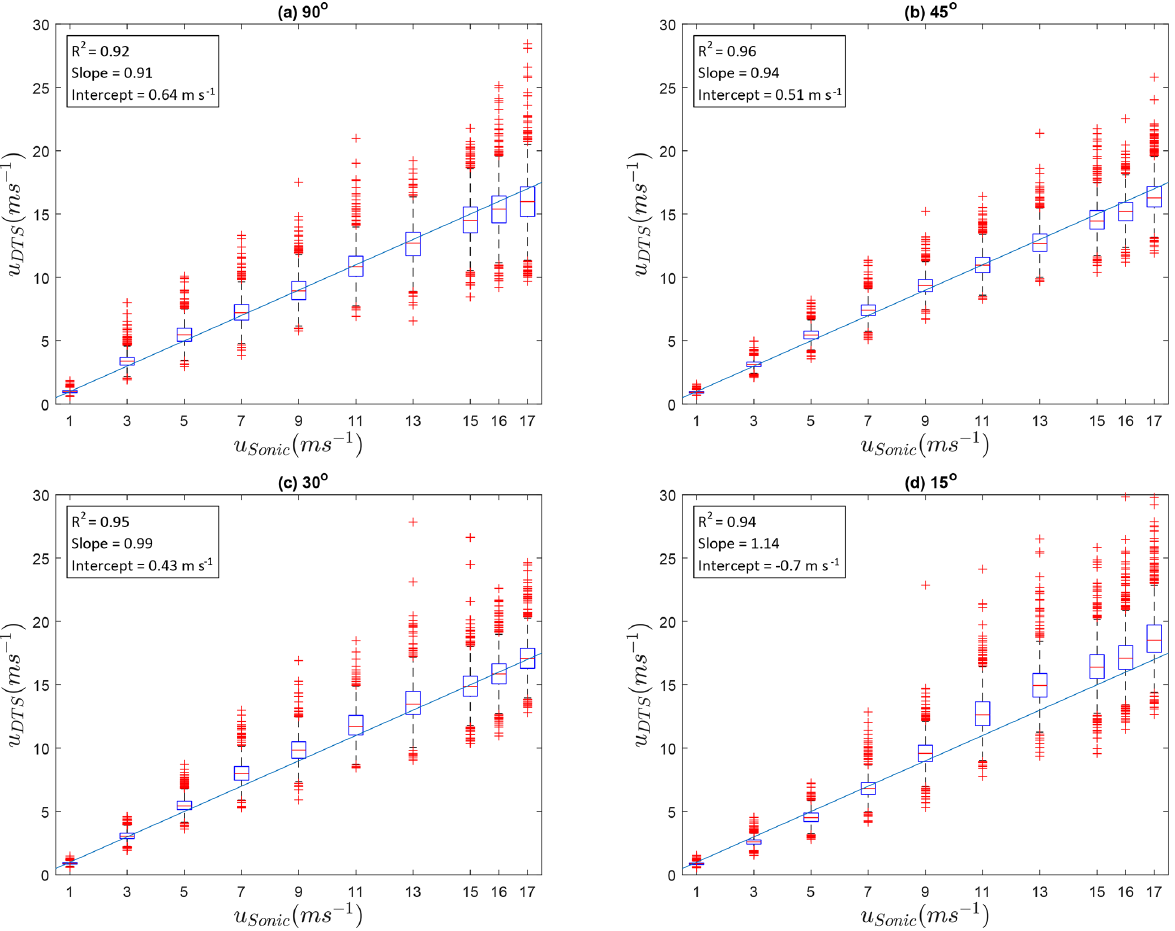
Figure B1. Comparison of AHFO and sonic anemometer wind speed at a 1s temporal resolution for the four different angles of attack: (a) 90 ◦ , (b) 45 ◦ , (c) 30 ◦ and (d) 15 ◦ ; n space = 10, n time = 1. The line represents the 1 : 1